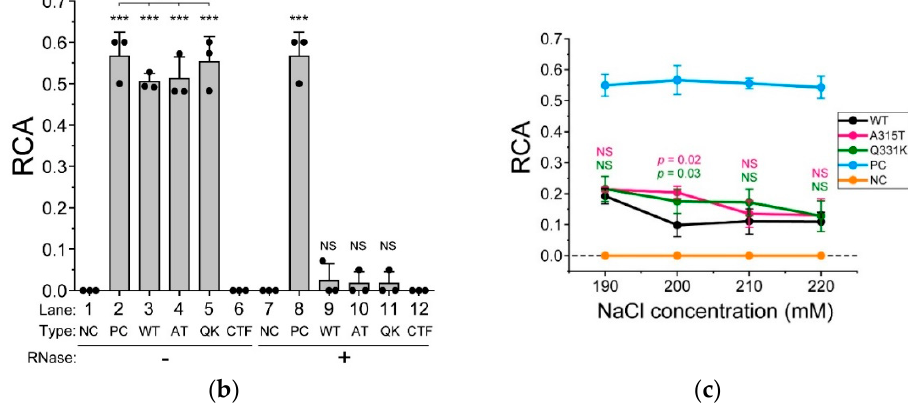
Figure 3. Biochemical interaction between TDP-43 and hnRNP A1. ( a ) confocal fluorescence images of Neuro2A cells expressing TDP-43-GFP and RFP-hnRNP A1. Scale bar = 5 μ m; ( b ) relative cross- correlation amplitude (RCA) between TDP-43-GFP and RFP-hnRNP A1 measured using FCCS. The dots denote the independent three trials of a series of transfection, cell lysis, and FCCS measurement. The bars indicate the mean ± SD (three trials). Type denotes wild-type TDP-43 (WT) or its ALS-associated mutants; A315T (AT) and Q331K (QK), in addition to the co-expression of both GFP and RFP monomers as an interaction-negative control (NC), expression of tandemly dimerized GFP and RFP as an interaction-positive control (PC), and 274–414 amino acids carboxy-terminal fragment of TDP-43 (CTF). *** The Student’s t -test compared to the negative control ( p < 0.001). NS: not significant ( p ≥ 0.05); ( c ) comparison of the RCA between TDP-43-GFP and RFP-hnRNP A1 as the NaCl concentration is increased in the cell lysate (190, 200, 210, and 220 mM). RFP-hnRNP A1 was co-expressed with the wild-type (WT, black), A315T (magenta), or Q331K (green) mutants of TDP-43. A mixture of GFP and RFP monomers and tandemly dimerized GFP and RFP were used as an interaction-negative control (NC, orange) and an interaction-positive control (PC, cyan), respectively. The dots denote the independent three trials of a series of transfection, cell lysis, and FCCS measurement. The bars indicate the mean ± SD (3 trials). p -values above the bars: Student’s t -test compared to the RCA of the WT at the same NaCl concentration (the colors correspond to the ALS-associated mutants); NS: not significant ( p ≥